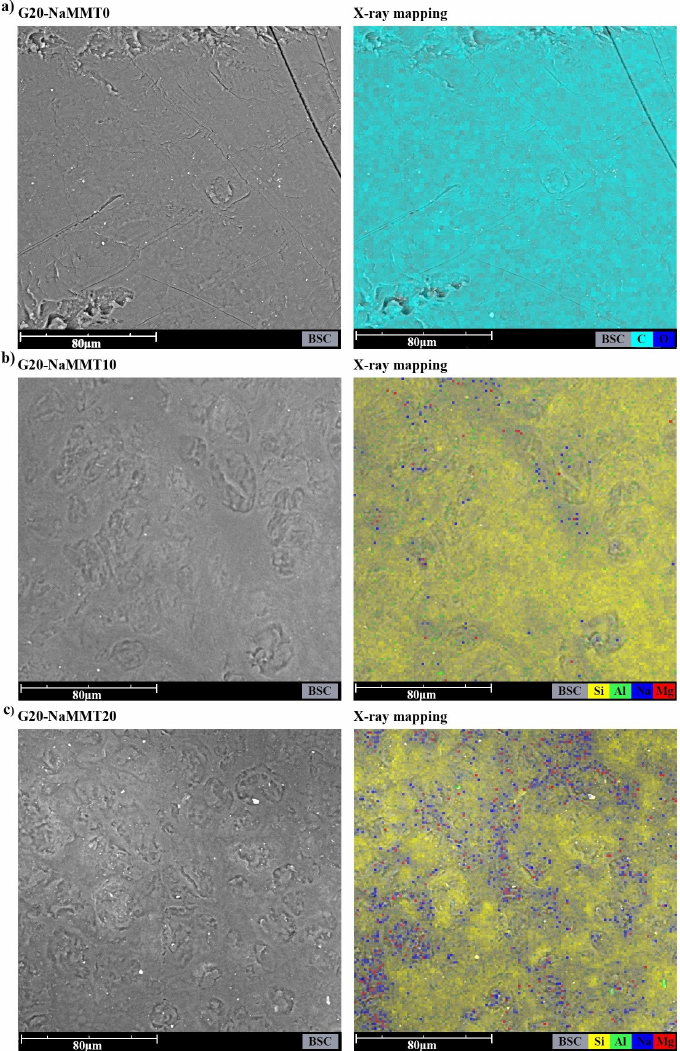
Figure 4. Scanning electron micrographs of representative starch – based films: (a) G20-MT0 conventional composites with 20 wt% glycerol concentration, (b) G20-F10 nanocomposites containing 10 wt% NaMMT clay with 20 wt% glycerol concentration and (c) G20-MMT20 nanocomposites containing 20 wt% NaMMT clay with 20 wt% glycerol